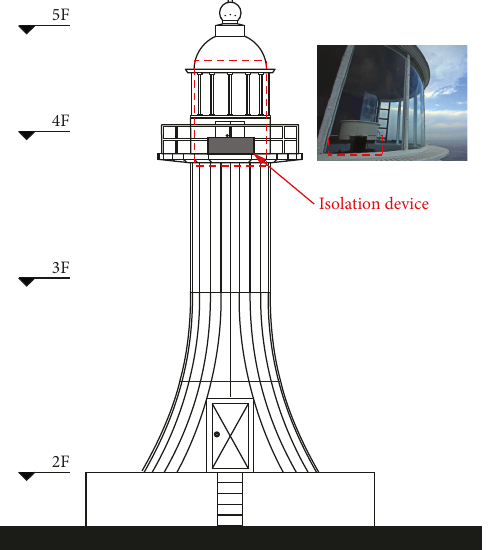
Figure 8: Case 2